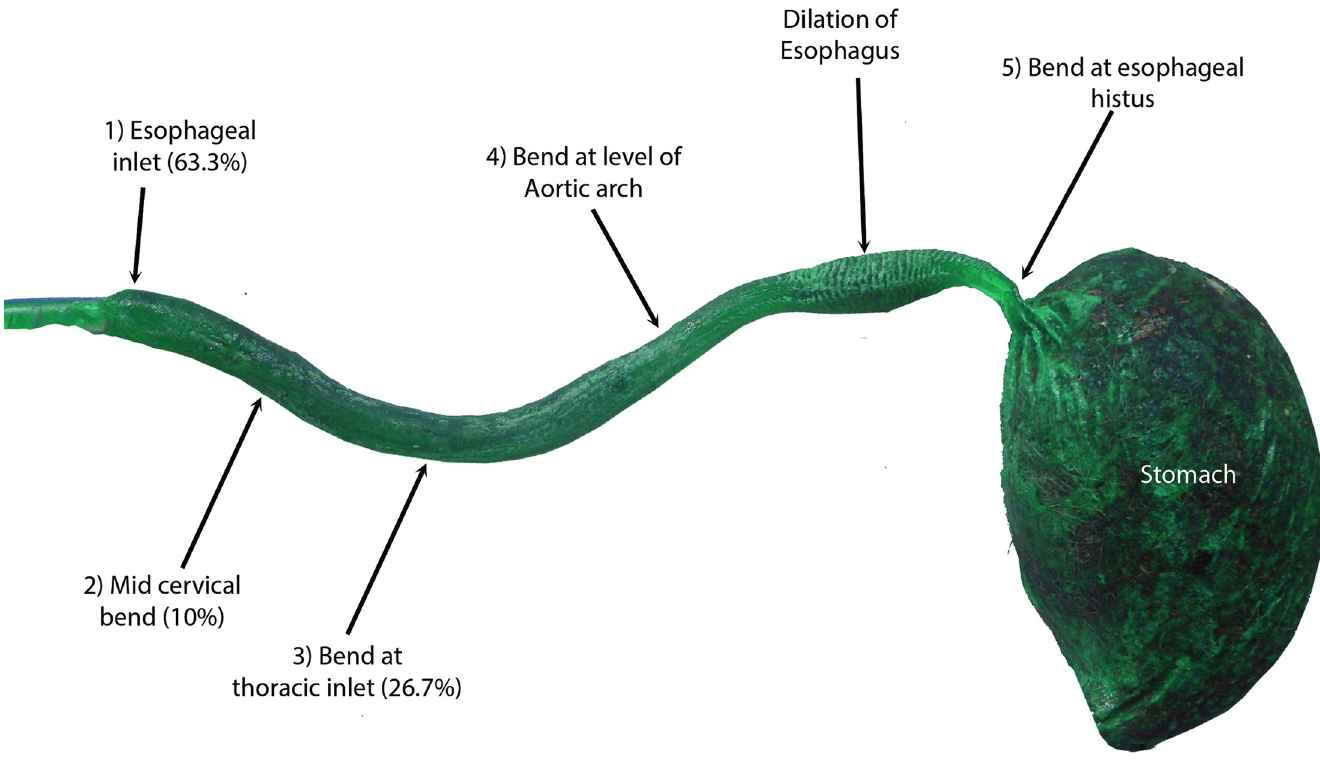
Fig 8. Kemapoxy 150 green-coloured corrosion cast of the oesophagus and stomach showing the main deviations of the oesophagus.